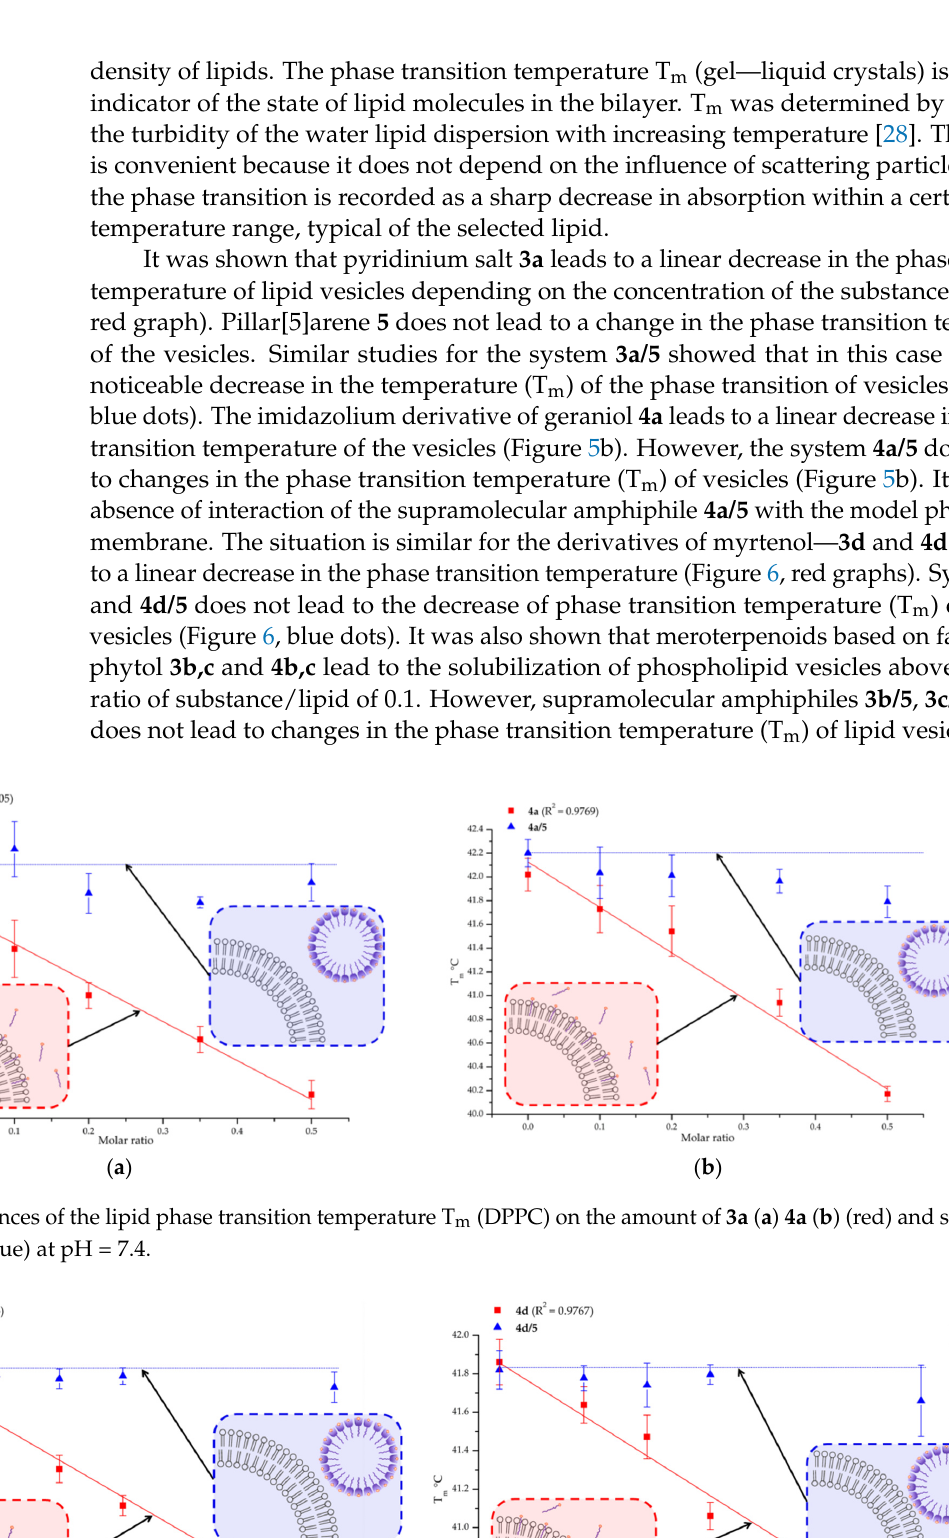
Figure 6. Dependences of the lipid phase transition temperature T m (DPPC) on the amount of 3d ( a ) 4d ( b ) (red) and systems 3d/5 ( a ) 4d/5 ( b ) (blue) at pH = 7.4.